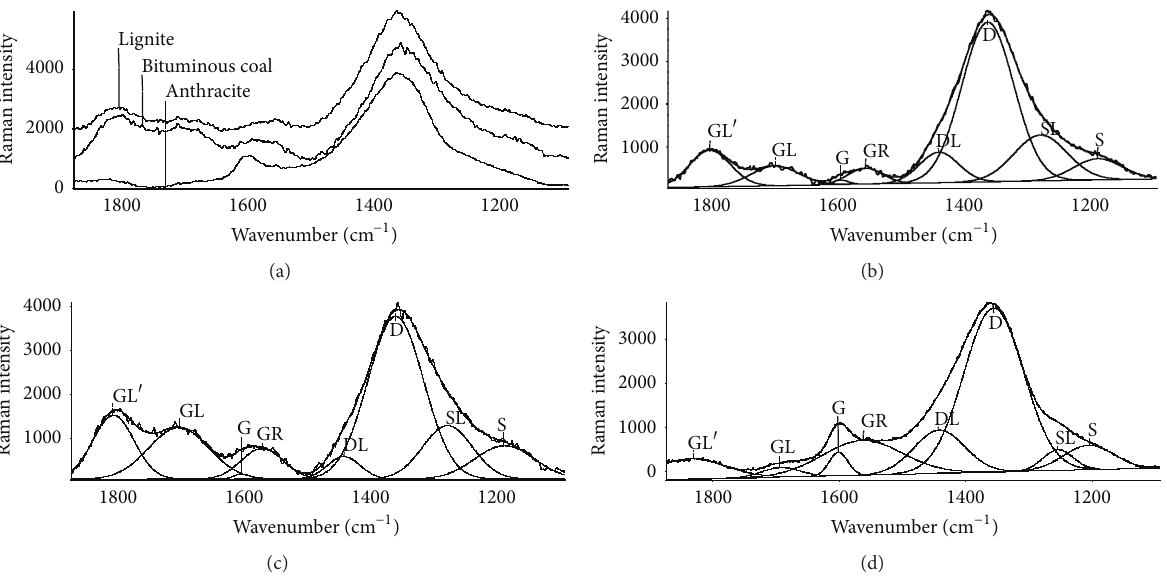
Figure 1: (a) Average Raman spectra of the three coals and deconvolution of the features associated with (b) lignite, (c) bituminous coal, and (d)